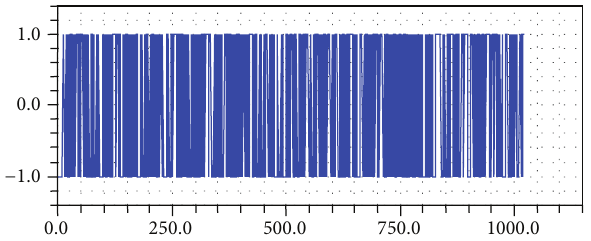
Figure 11: DDL based C/A-GPS Gold